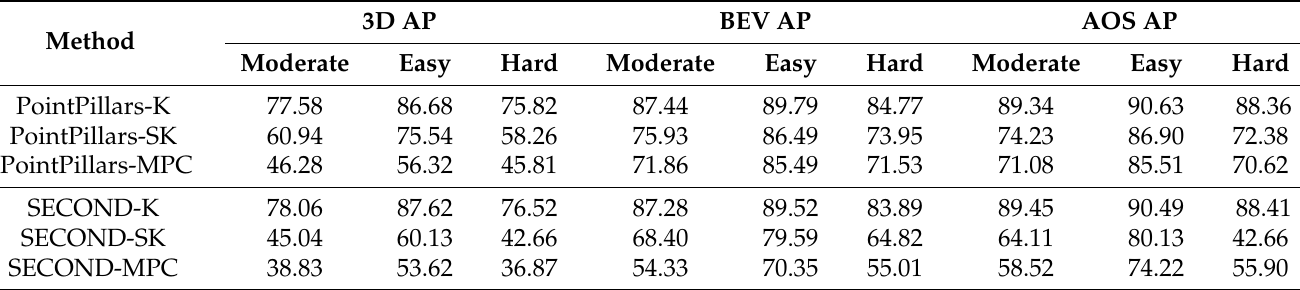
Table 2. Performance on the KITTI validation set of detectors trained with the real KITTI and ShapeKITTI.